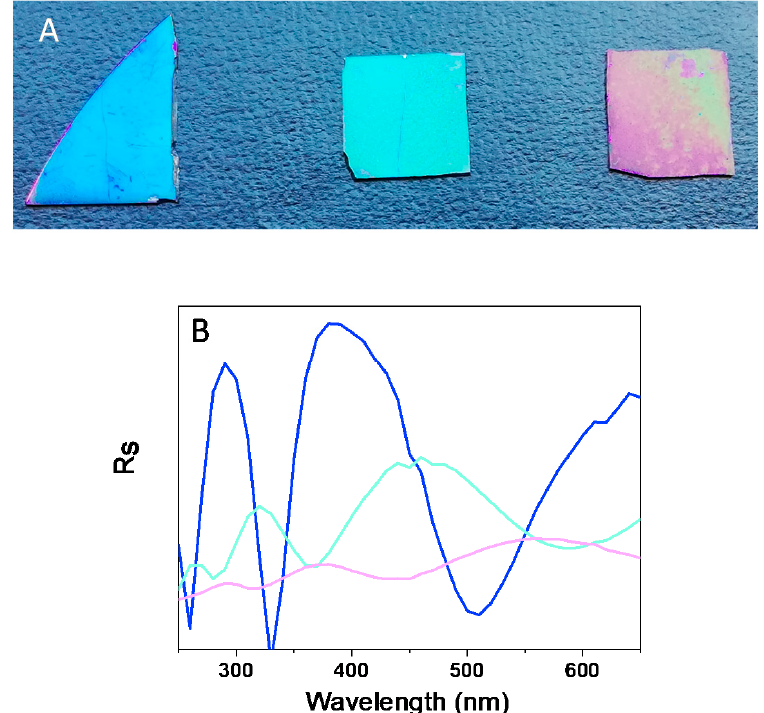
Figure 1. ( A ) Image of silicon nitride wafers after exposing the silicon nitride wafers for 9 h to the polymerization medium in the presence of different NaCl concentrations: 0.23, 0.40 and 0.87 M, from left to right. ( B ) Perpendicular reflectance (Rs) spectra at 70° of surfaces obtained with [NaCl] = 0.23 (blue), 0.40 (cyan) and 0.87 M (magenta).